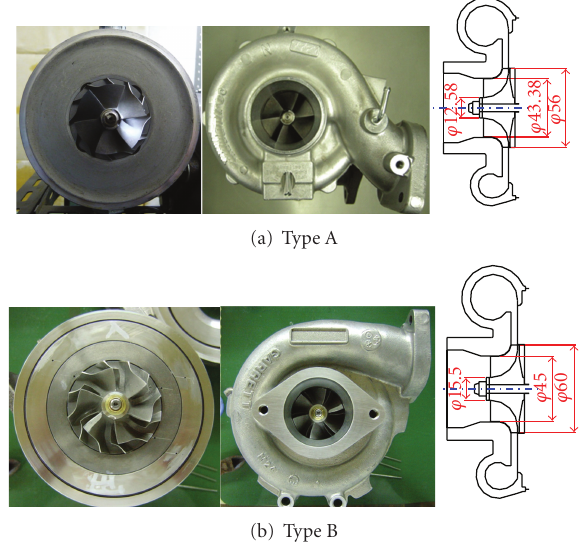
Figure 2: Tested impeller (unit: mm).